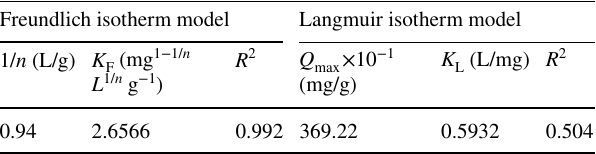
Table 4 Freundlich and Langmuir parameters for EBT adsorption isotherms